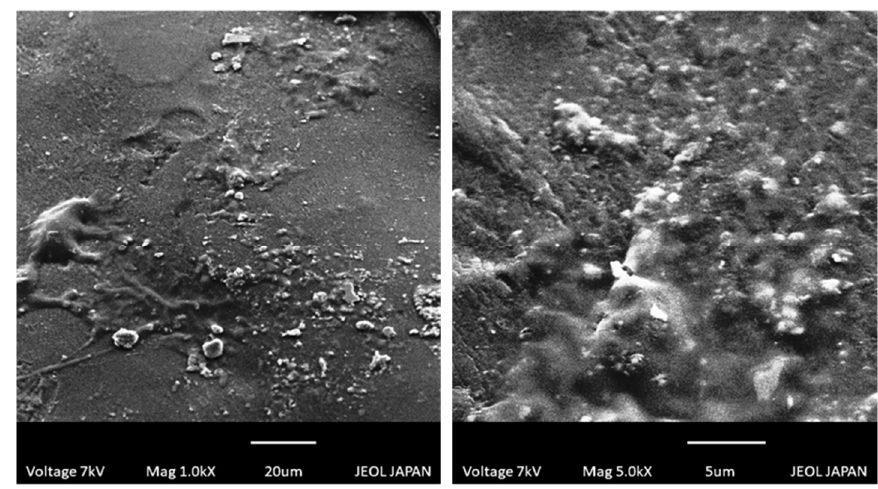
Figure 7. SEM photomicrographs of developed hydrogels.